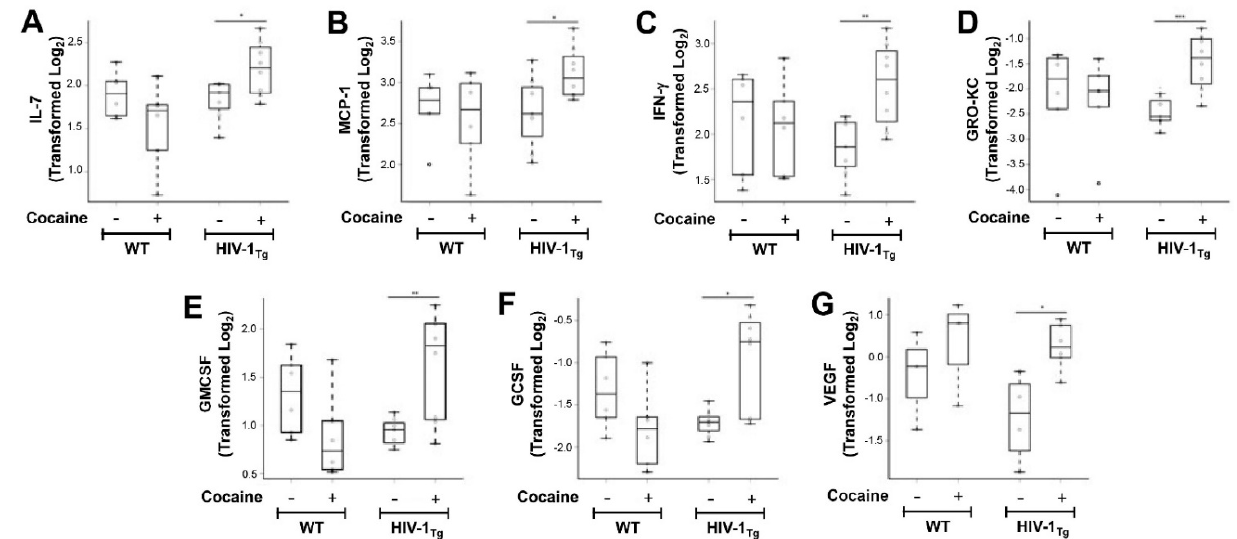
Figure 2. Cocaine self-administration regulates cortical interleukin and growth factor levels in HIV- 1 Tg rats. Frontal cortex (fCTX) brain tissue was collected, and equivalent total protein lysates were assayed for innate immune markers from WT saline-yoked ( n = 7), WT cocaine SA ( n = 8), HIV-1 Tg saline-yoked ( n = 6), and HIV-1 Tg cocaine SA ( n = 6) male rats. Protein levels for IL-7 ( A ), MCP-1 ( B ), IFN- γ ( C ), GRO-KC ( D ), GM-CSF ( E ), G-CSF ( F ), and VEGF ( G ) are shown. Log 2 transformation was performed prior to statistical analyses since some expression levels were not normally distributed. * p < 0.05, ** p < 0.01, *** p < 0.001.